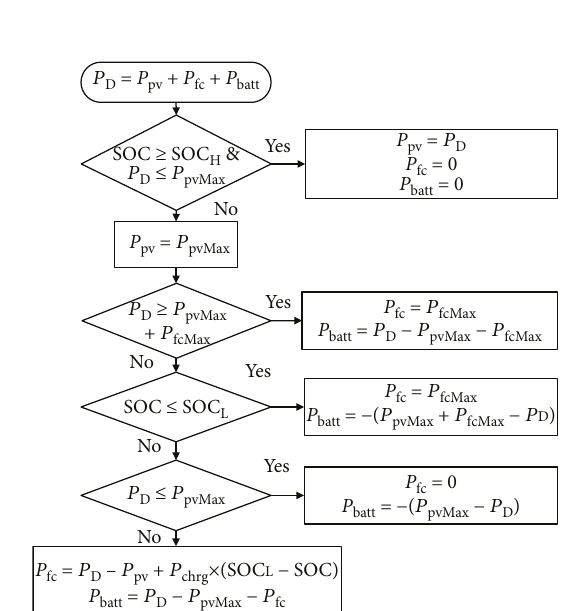
Figure 12: State of each power source.